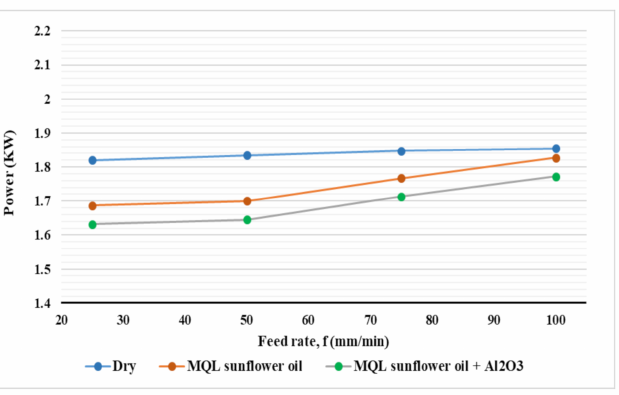
Figure 8. Effect of cooling strategies on power consumption with different feed